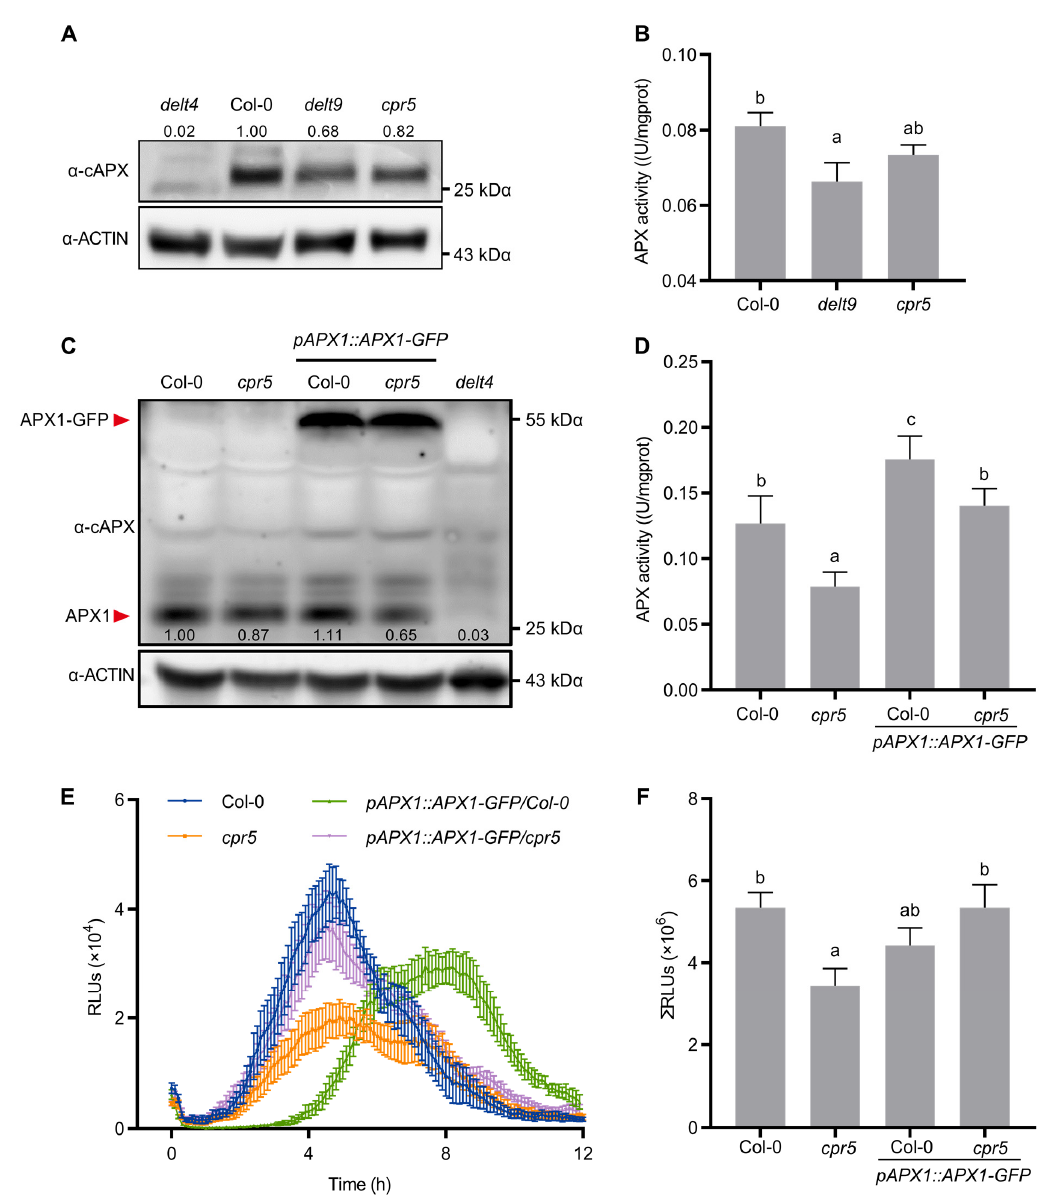
Figure 4. cpr5 mutants show reduced APX1 abundance. ( A ) APX1 protein abundance. Total proteins were extracted from 4-week-old plants and detected by immunoblot analysis using an α -cAPX antibody. A null allele of apx1 (named delt4 ) was used as a negative control. Numbers at the top of the blots indicate the relative levels of APX1 proteins normalized with the actin levels. The experiment was repeated twice with similar results. ( B ) APX activity. Crude enzymes extracted from 5th–7th rosette leaves on 4-week-old plants. APX activity was determined by ascorbate oxidation. Data are means ± SD (n = 2–3). Letters above bars indicate significantly different values among groups ( p ≤ 0.05; one-way ANOVA). ( C ) APX1 protein levels in Col-0, cpr5 , and transgenic plants overexpressing APX1. Total proteins were extracted from 4-week-old leaves and detected by immunoblot analysis using an α -cAPX antibody and α -actin antibody as the loading control. Numbers at the bottom of the blots indicate the relative levels of APX1 proteins normalized with the actin levels. The experiment was repeated twice with similar results. ( D ) APX activity in Col-0, cpr5 , and